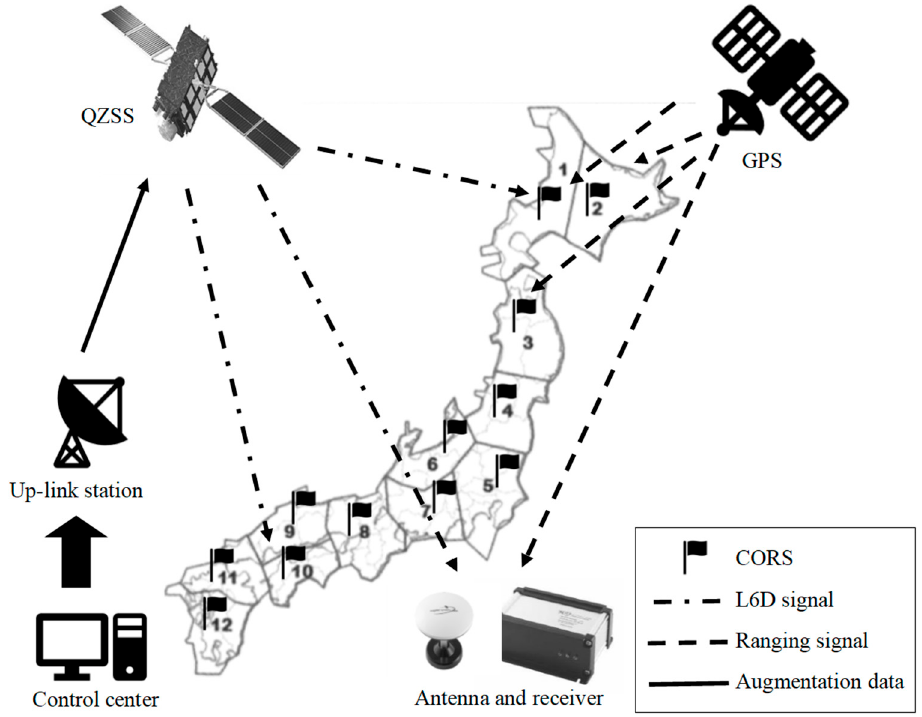
Figure 4. Diagram of the Centimeter Level Augmentation Service (CLAS) positioning augmentation system.